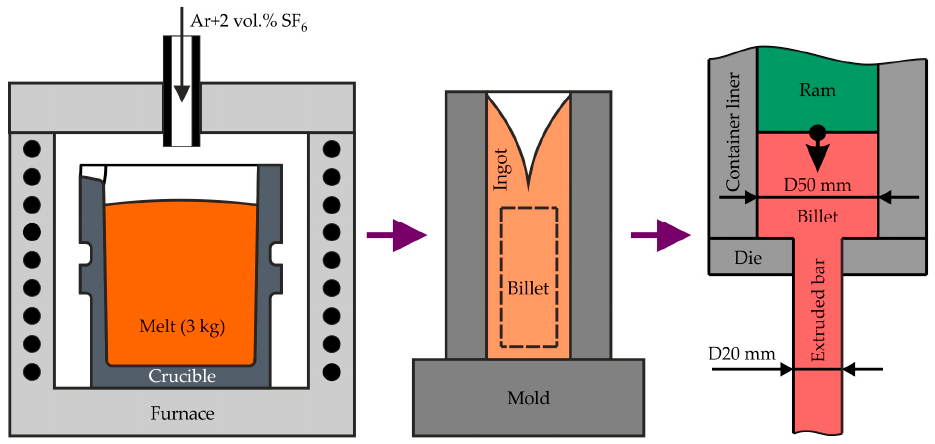
Figure 1. The scheme of extruded bars processing from casting to hot extrusion. Table 1. Elemental compositions of the prepared alloys.